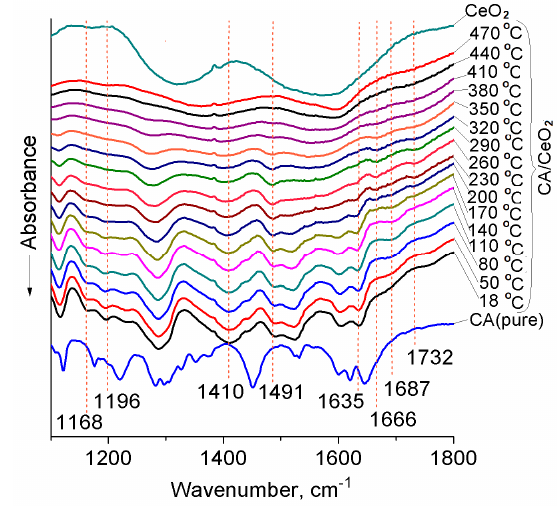
Figure 2. FT–IR spectra of CA/CeO 2 (0.6 mmol/g) at different temperatures.